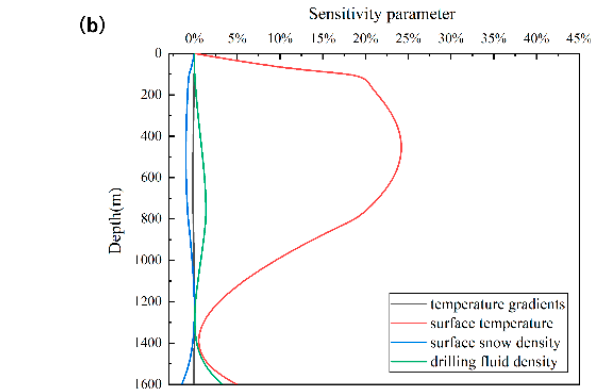
Table 4. Sensitivity analysis factor values.